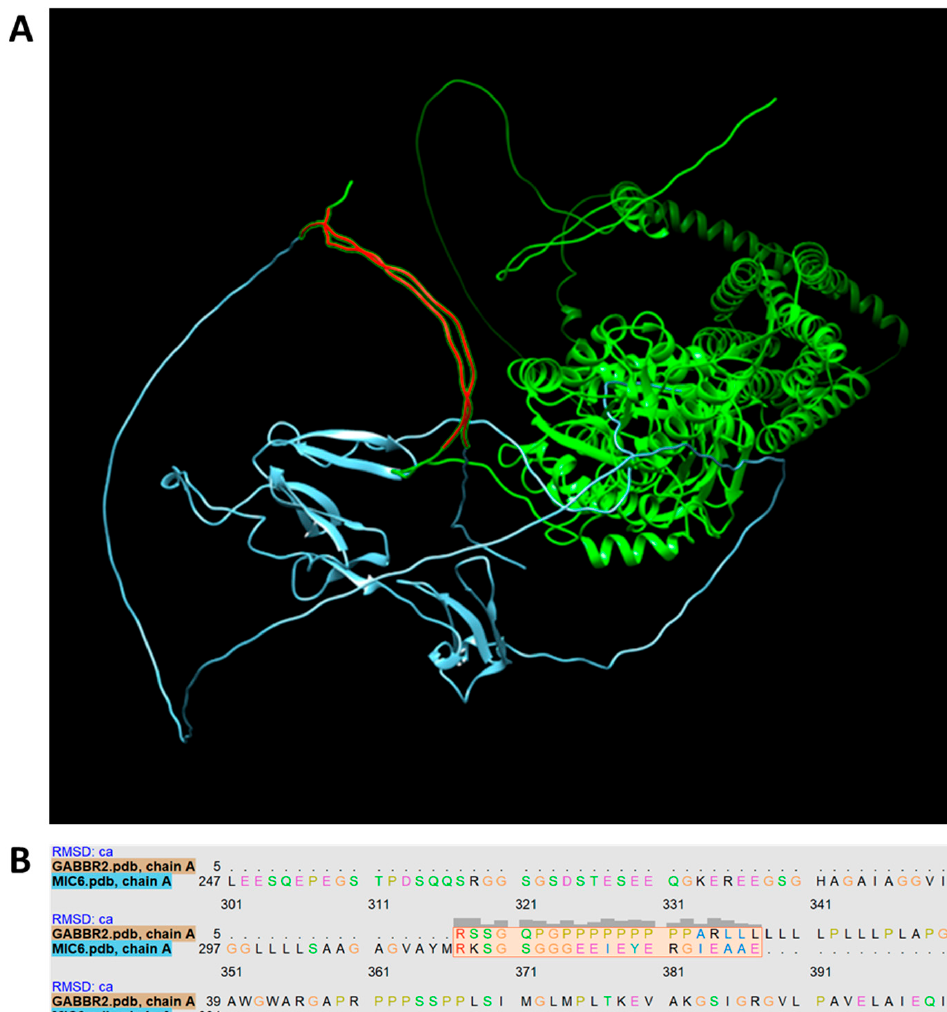
Figure 7. Structural comparison between GABBR2 central nervous system protein (green) and MIC6 T. gondii protein (cyan). ( A ) The three-dimensional structures of the GABBR2 and MIC6 proteins were downloaded from the Uniprot platform and aligned using the UCSF Chimera program, shared sequences between both proteins in red. ( B ) The Matchmaker extension performs the alignment of the sequences of both proteins and calculates the best alignment score. Amino acids 5 to 25 of GABBR2 and 314 to 334 of MIC6 have the best matching sequence.